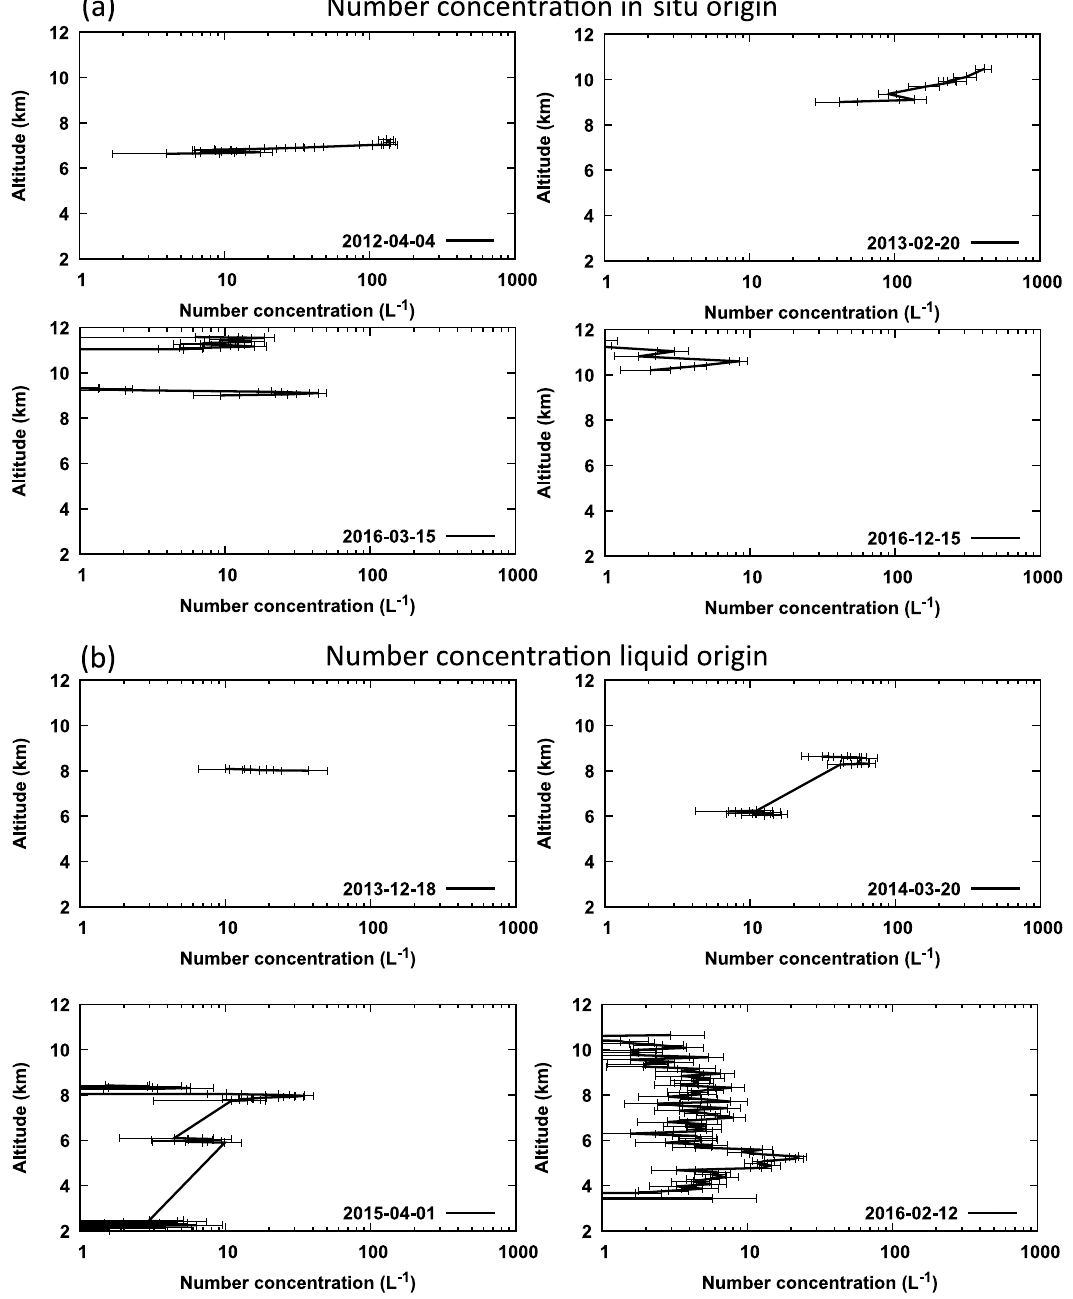
Figure 8. PSDs at different cloud levels for all measurement days ( a : in situ origin; b : liquid